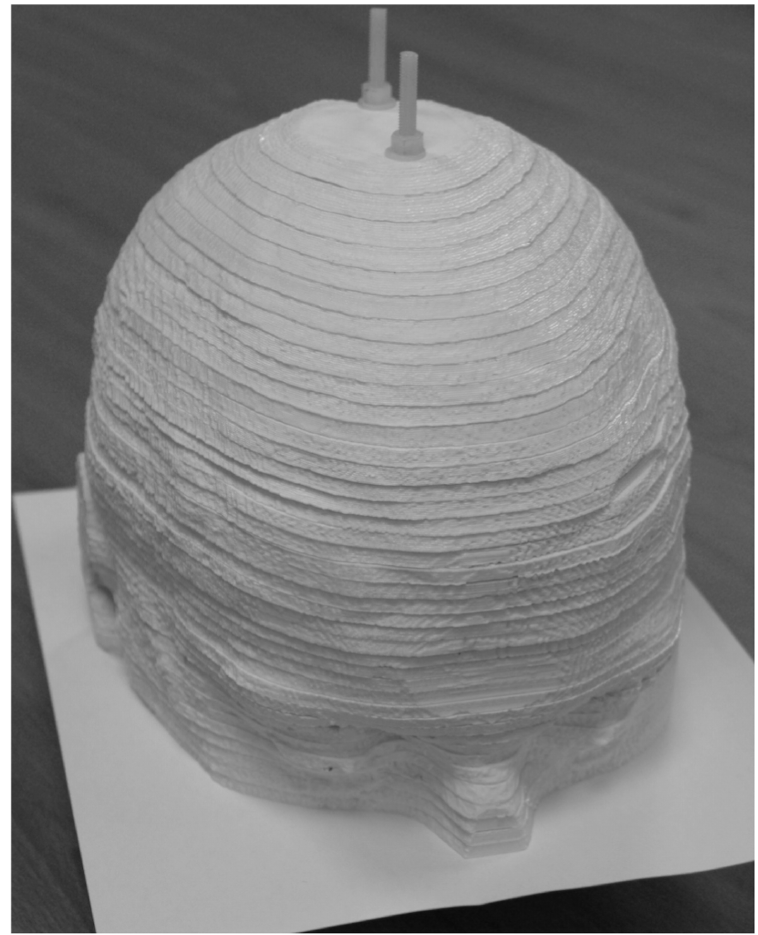
Figure 2. The brain phantom developed by Negus et al. [67] follows a different approach compared to fillable phantoms. It is a sandwich of 3D-printed slabs for attenuation and paper for activity distributions. The image was reproduced under license from the American Association of Physicists in Medicine and John Wiley & Sons, Inc. (Hoboken, NJ,